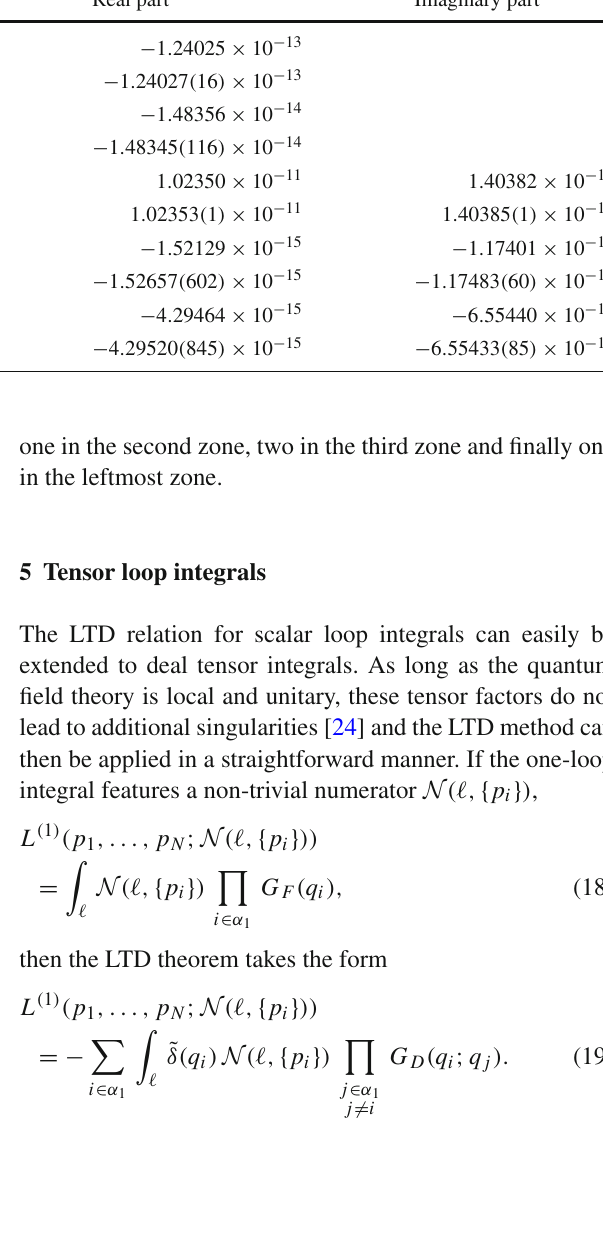
Scalar pentagon Real